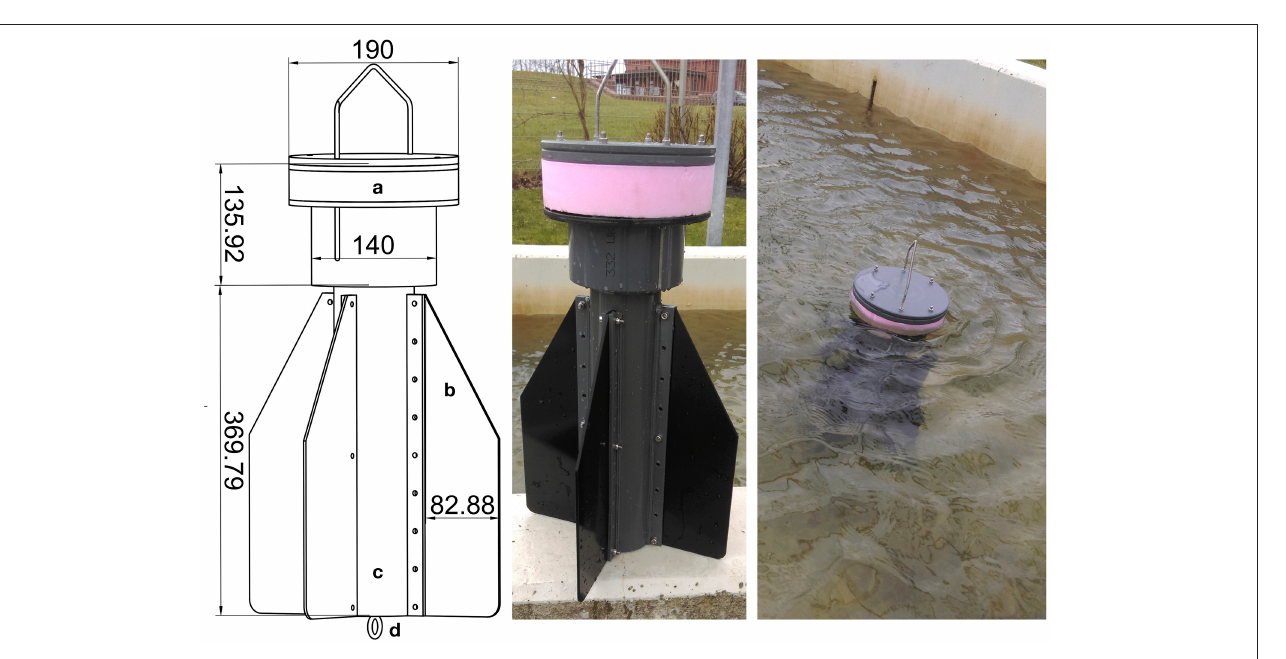
FIGURE 2 | Drifter design: (a) buoyant part of the housing which contains the GPS-position and signal transmission unit, (b) exchangeable drag-reducing wings, (c) lower part of the housing which contains the battery pack and additional ballast, (d) ring screw for optional mounting of an external subsurface drogue. Dimensions are given in